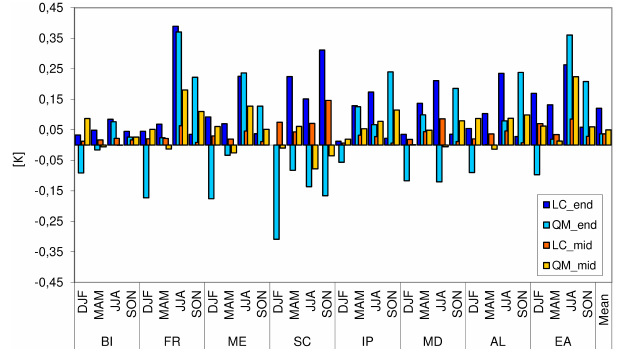
Figure 7. Estimated errors in the multi-model mean CCS due to intensity-dependent model errors. The reference period is 1971– 2000. The orange colors refer to CCSs in the mid-21st century (2021–2050), the blue colors to the end of the 21st century (2070– 2099). Light colors correspond to the estimation of the error by QM, dark colors to LC.